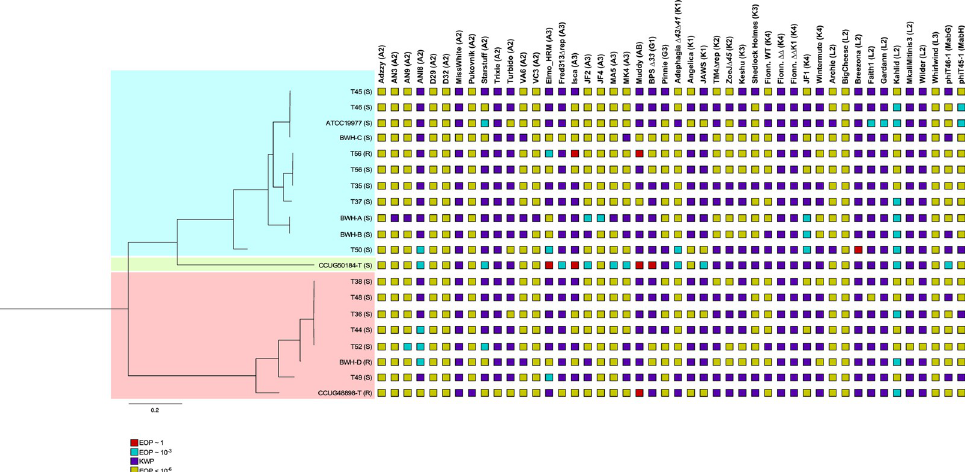
Fig 9. Phage susceptibility profiles of M . abscessus strains. M . abscessus strains and their phylogenetic relationships are shown at the left, together with the infection profiles of a broad set of phages. Subspecies abscessus , bolletii , and massiliense strains are shaded aqua, green and red, accordingly. Phage names are shown at the top, together with their cluster designation in parentheses. Phage infection is indicated according to the key below, according to the efficiency of plating relative to a control strain ( M . smegmatis for most phages): Red box, EOP of 1, Aqua box, EOP of ~10 − 3 , purple box, killing without plaquing (KWP), or yellow box, infection < 10 − 6 . Examples of these phenotypes are shown in S14 Fig.